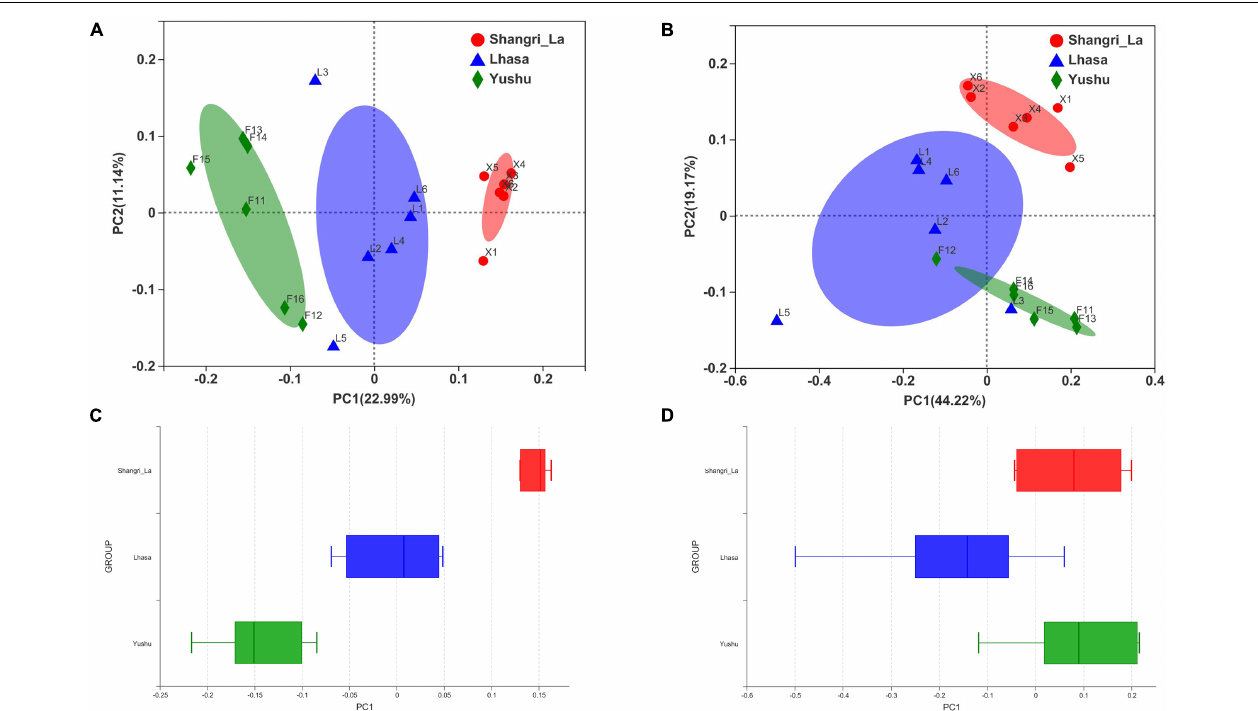
FIGURE 3 | Principal coordinates analysis (PCoA) of gut microbiota between different regions. (A) PCoA results based on unweighted UniFrac distance of bacterial communities from different regions. (B) PCoA results based on weighted UniFrac distance of bacterial communities from different regions. (C) The distinct separation of samples from different regions shown on the PCo1 axis based on weighted UniFrac distance. (D) The distinct separation of samples from different regions shown on the PCo1 axis based on unweighted UniFrac distance.